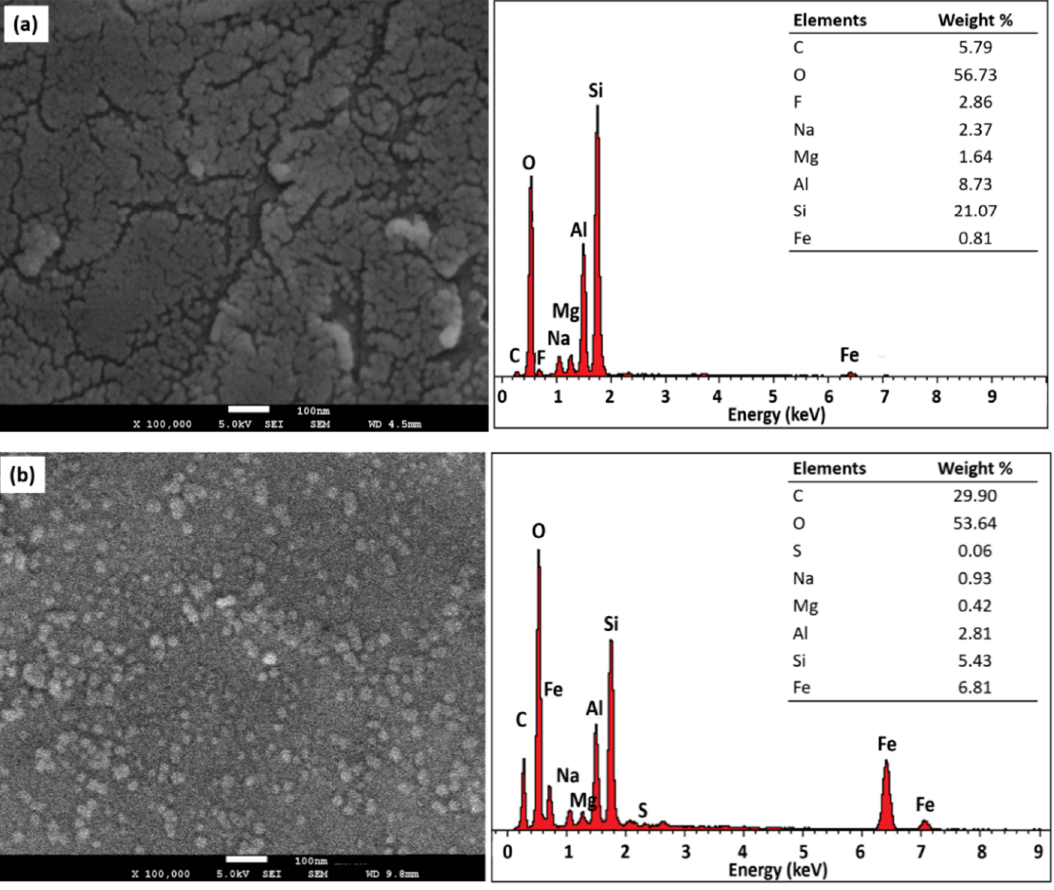
Figure 4. FESEM images and EDX spectra of ( a ) pristine MMT and ( b ) MMT/CR/Fe 3 O 4 -NCs (inset: elements composition).